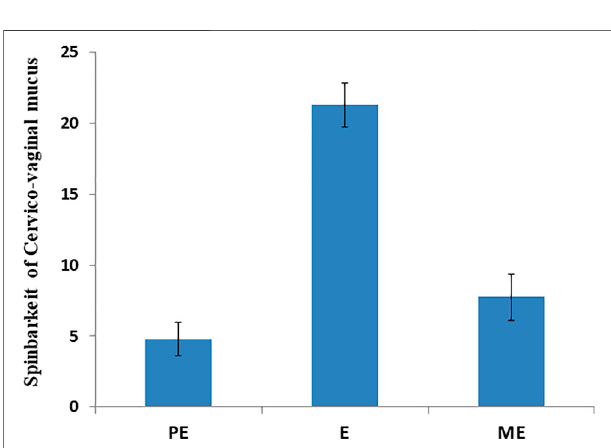
FIGURE4| Spinnbarkeitvalueofcervicovaginalmucusduringproestrus (PE), estrus (E), and metestrus (ME) stages of the buffalo estrous cycle.